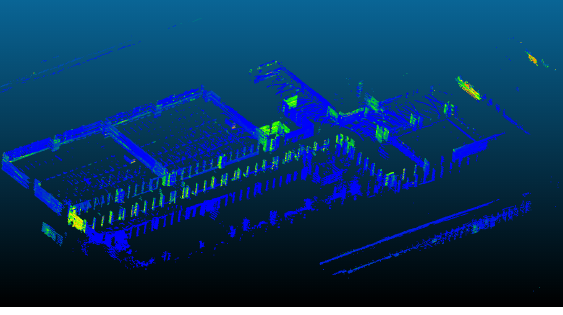
Figure 10. 3D Point Cloud Map.